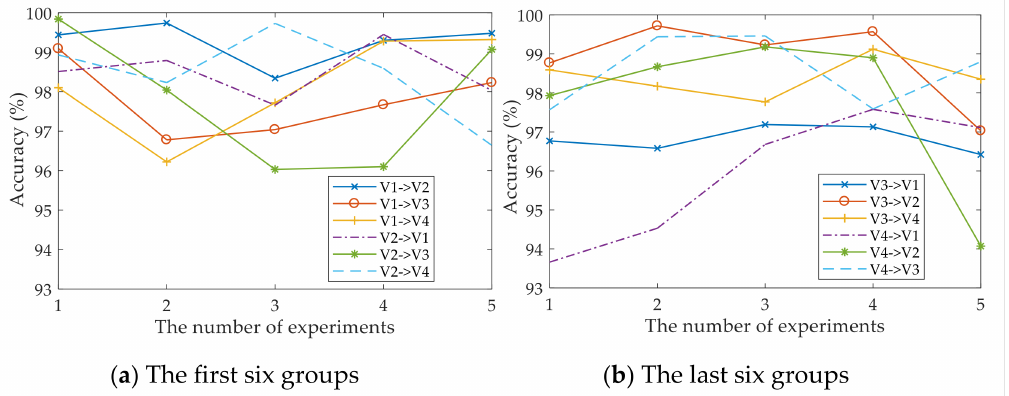
Figure 10. The five consecutive test results of the DAN-DAM model in diverse transfers for private datasets.